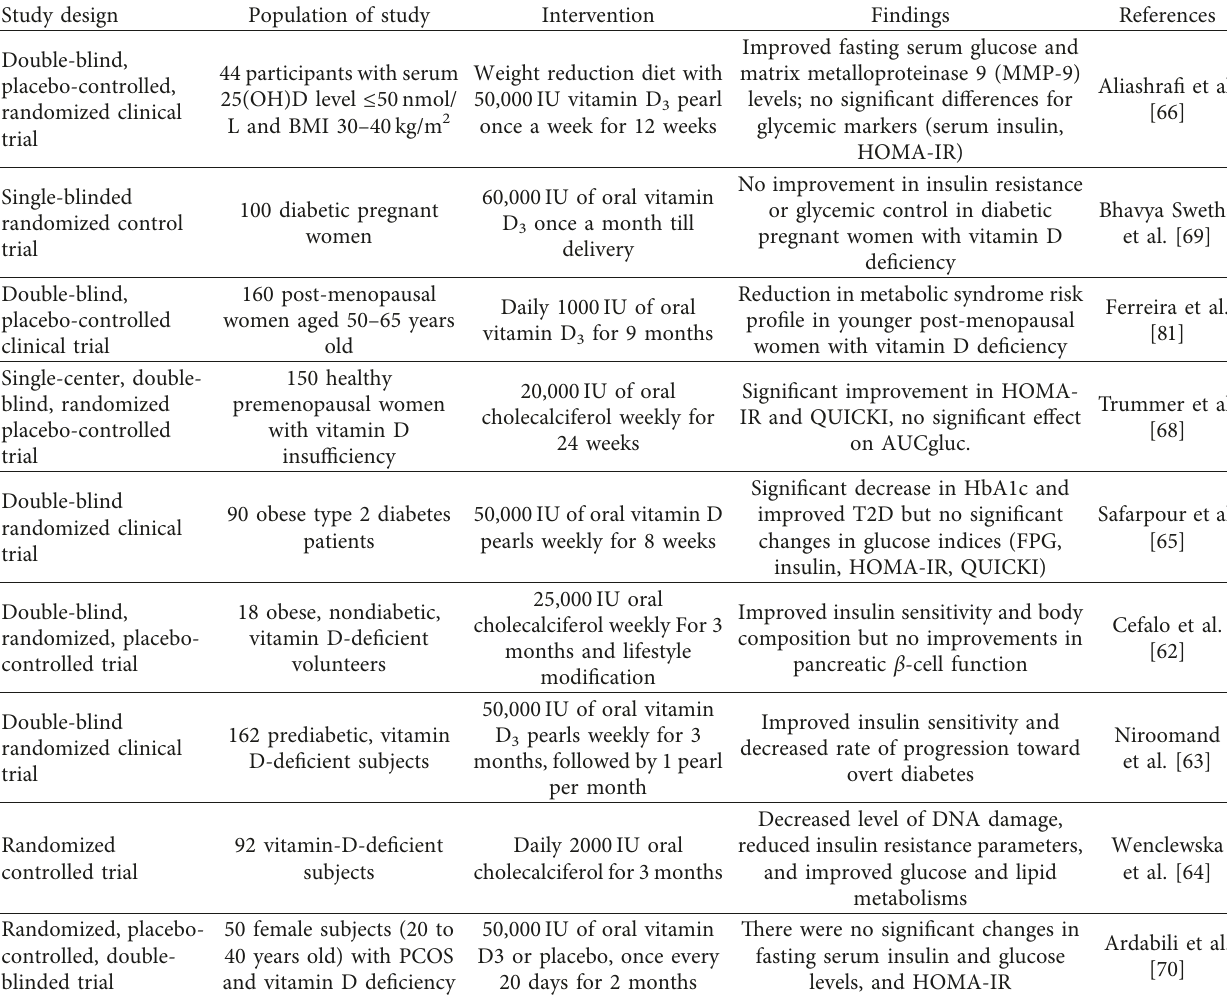
Table 2: Interventional clinical trials on the effects of vitamin D supplementation on insulin